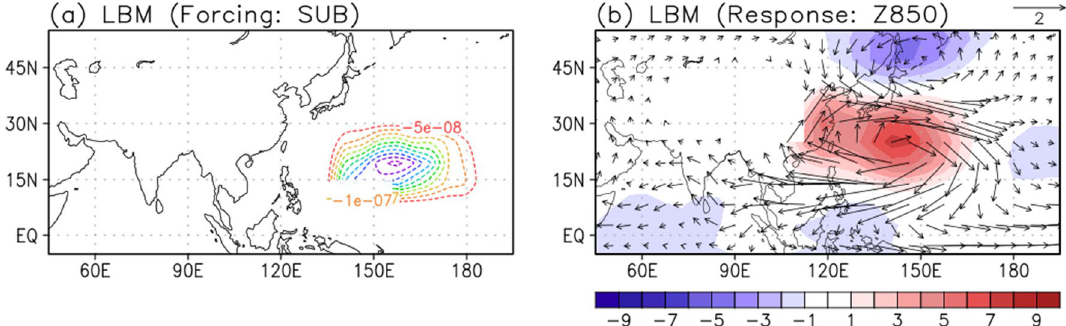
Figure 5. ( a ) The subtropical WNP (140° E–180°, 10°–30° N) diabatic forcing for LBM simulation based on the regressed rainfall pattern in Fig. 4a. ( b ) The geopotential height (shading; m) and wind (vector; m/s) anomalies of LBM simulation in August at 850 hPa during 1979–2020 for the forcing in the ( a